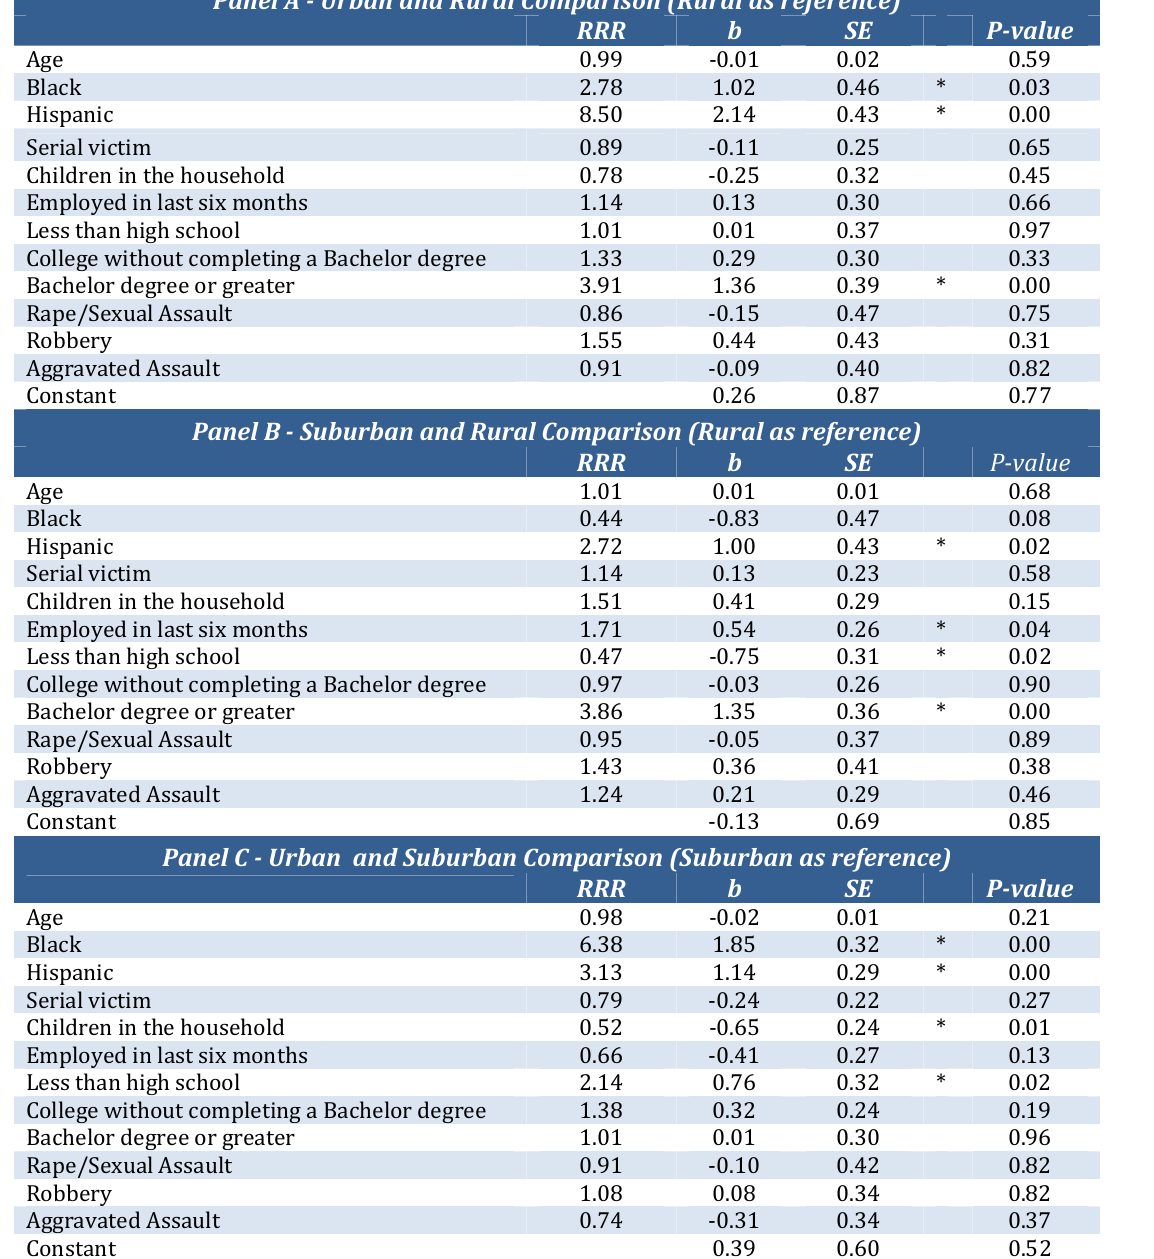
Table 2 presents data from survey‐weighted multinomial logistic regressions. Table 2: Multinomial logistic regression findings (n=1,827) Panel A ‐ Urban and Rural Comparison (Rural as reference)